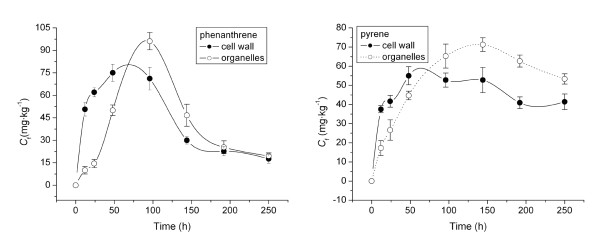
Concentrations of phenanthrene (a) and pyrene (b) in root cell walls and organelles as a function of time. Cf means concentrations of phenanthrene and pyrene in root subcellular fractions.